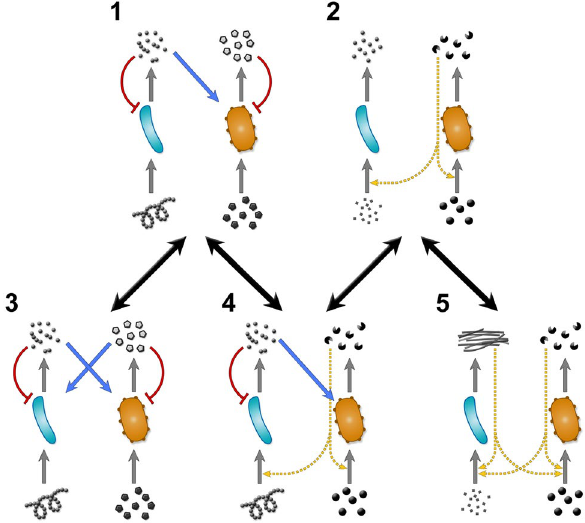
Figure 7. Possible evolutionary transitions (thick black arrows) between different syntrophic interaction topologies of cross-feeding (1, 3, 4) and collaborative feeding (cross-facilitation) (2, 5, 4). Grey and blue arrows indicate trophic interactions, red curves indicate inhibitory and dashed yellow arrows catalytic interactions. There are other possible cases not displayed, but we assume that further topologies are isomorphic to displayed ones up to a symmetric re-labelling of species and interactions. We omit cases where a species simultaneously exerts both a trophic and a catalytic effect on the partner, as that would require multiple products of the same species and thus lead to topologies that are not isomorphic (up to a re-labelling of species) to any of the depicted ones. Different mutants can appear, inheriting the interaction topology of either species 1 or 2. Panel 1 corresponds to flow-through syntrophy, while panel 3 may represents the recycle type if the end products x 1 and x 2 represent different states of the same molecule and are stoichiometrically coupled (cf. Fig. 6). Transformative interactions (normal arrows) are not expected to evolve to catalytic ones, or vice versa. We have explicitly tested transitions 1 ↔ 3 and 2 ↔ 5 in the main text (and 1 ↔ 4 in Supplementary Information SI